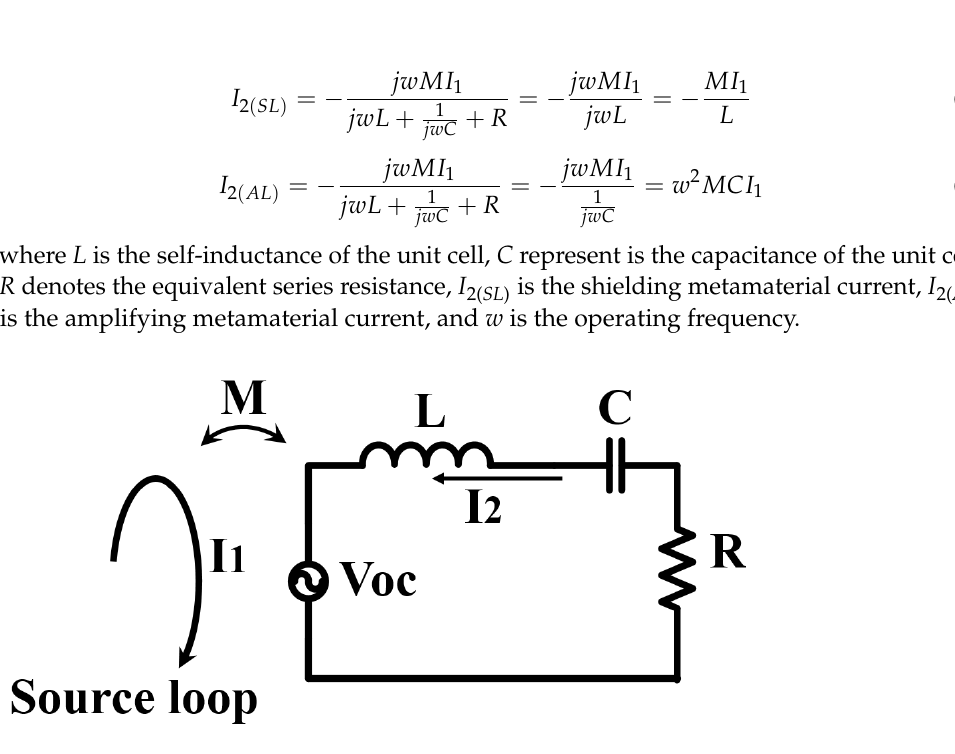
Figure 1. Circuit model of the metamaterial unit cell and source loop.